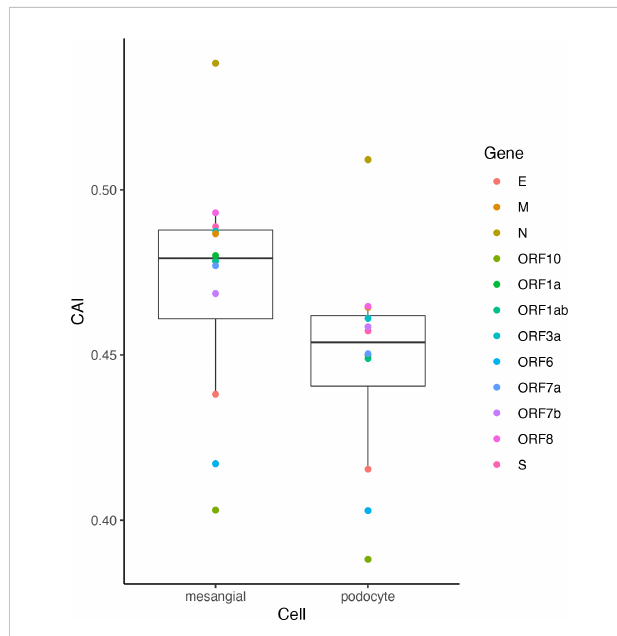
FIGURE 13 The CAI value distribution of different ORFs of the original SARS-CoV- 2 strain in two cell types in the glomerulus (mesangial cells and podocytes) from bulk RNA-seq datasets shown by box plot. Each box shows the CAI value distribution of SARS-CoV-2 reference ORFs in a speci fi c cell type.